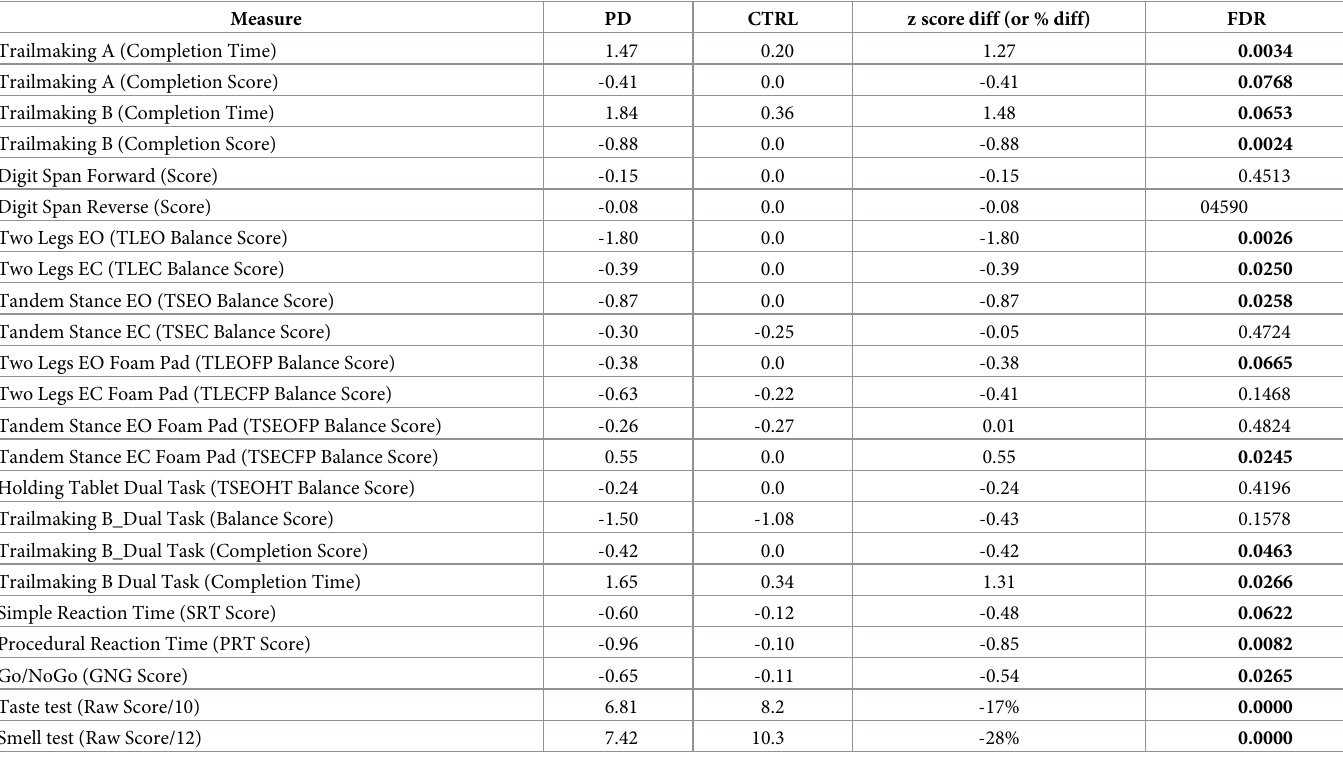
Table 3. Motor, cognitive, and sensory outcome